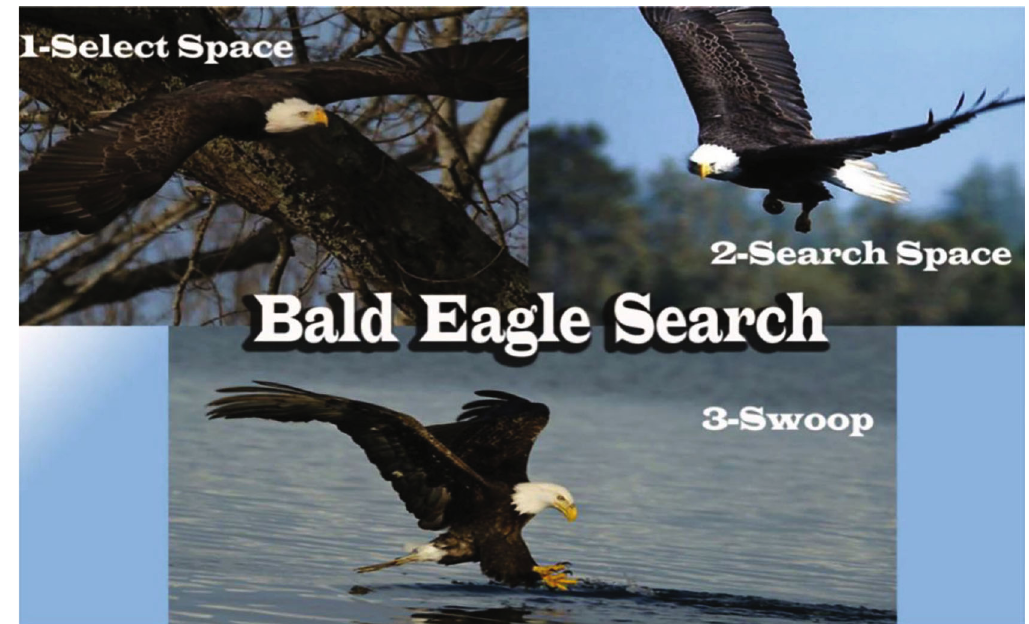
Figure 4: Bald eagle hunting behaviour [55].